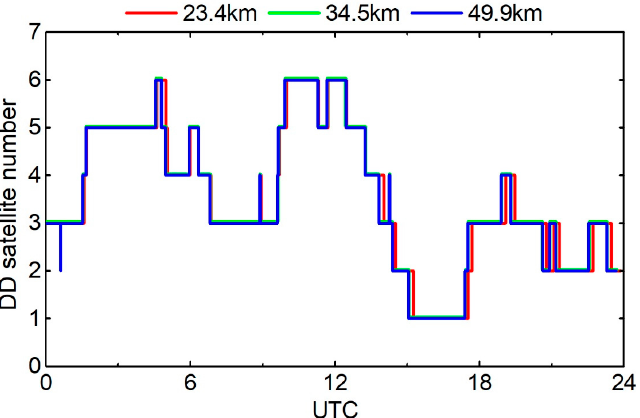
Figure 2. The number of Galileo double-differenced (DD) satellite pairs in three baselines.